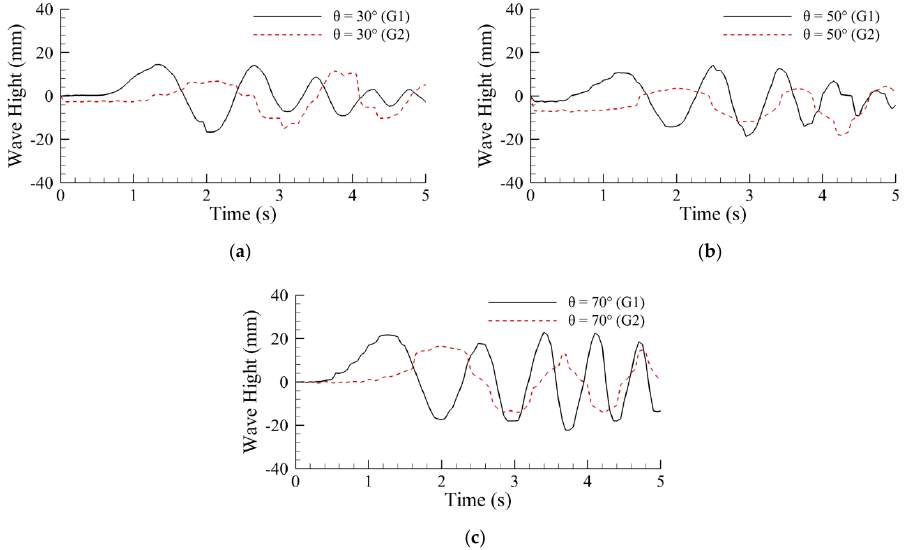
Figure 11. The temporal evolution of the water elevation in G 1 and G 2 with the subaerial landslide: ( a ) θ = 30 ° ; ( b ) θ = 50 ° ; and ( c ) θ = 70 ° . ( a ) θ = 30 ◦ ; ( b ) θ = 50 ◦ ; and ( c ) θ = 70 ◦